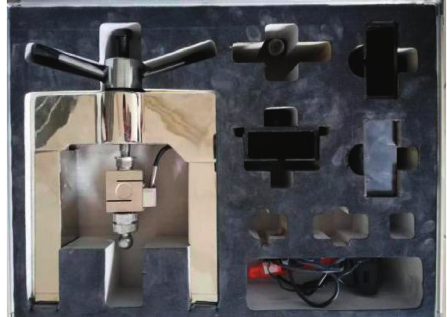
Figure 5: HC-MD60 high-precision rivet